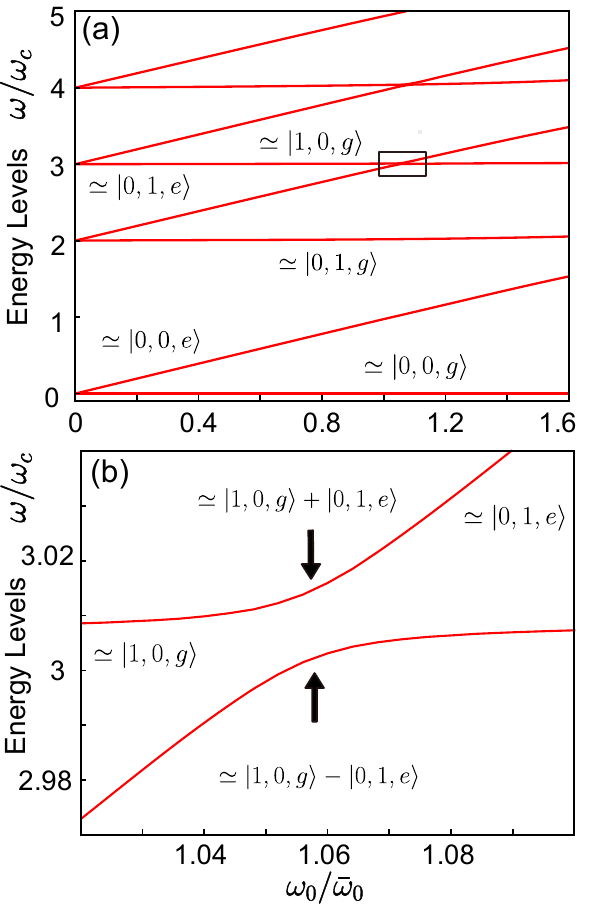
Figure 3: Energy spectum obtained from the numerical diagonalization of (11). (a) Lowest normalized energy levels versus the qubit frequency. (b) Enlarged view of the spectrum inside the rectangle in (a) showing the presenceofanavoidedlevelcrossing.Parametersaregiveninthetext.